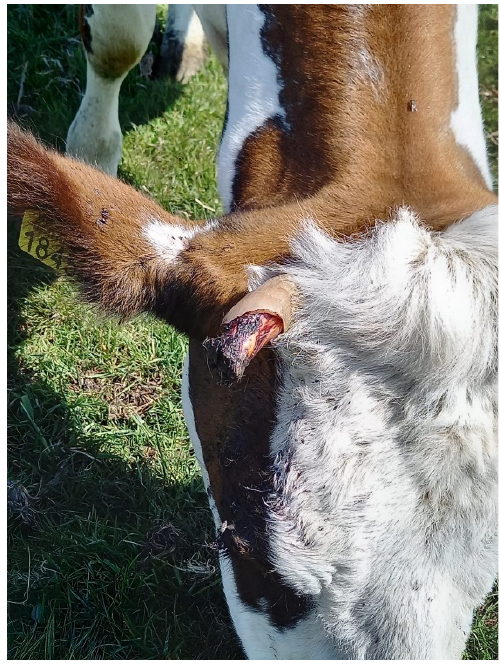
Figure 1. A cow at one of the farms with a broken horn. The bony core can be clearly distinguished from the keratin sheath, and it is visible that the bone contains blood vessels. ( © Lara de Keijzer). In bovids, horns have several functions. In males, during intrasexual competition for mates, horns are either used as a weapon to attack the opponent, or as a defensive shield [14,15]. Females use their horns to defend themselves and their offspring and, like males, as weaponry in intrasexual competition for resources [14,16,17]. Horns can also be used for self-grooming by scratching body parts that are difficult to reach [18,19]. Bovine horns consist of a hollow bony core that is projected from the frontal bone, covered by a keratin sheath [20]. After approximately six months of age, the bony core is pneumatized from the caudal frontal sinus. The bony core of the horn, as visible in Figure 1, is supplied with blood from the cornual artery that stems from the superficial temporal artery [21]. The horns are innervated by the cornual branch of the zygomaticotemporal nerve, a division